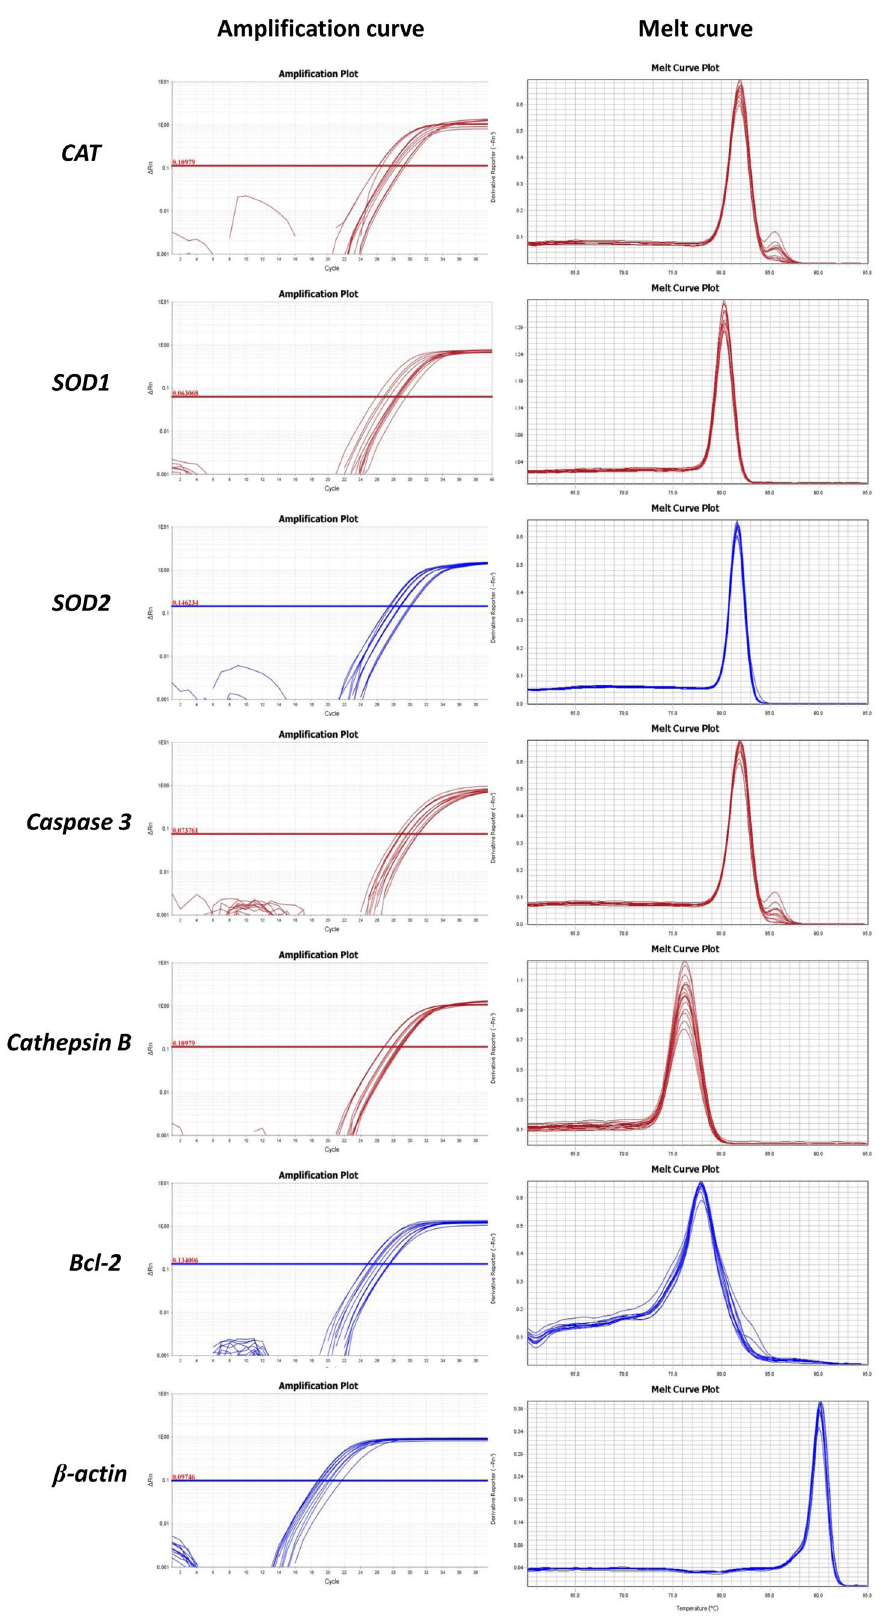
Figure 8. The amplification curves and melt curves in quantitative real-time